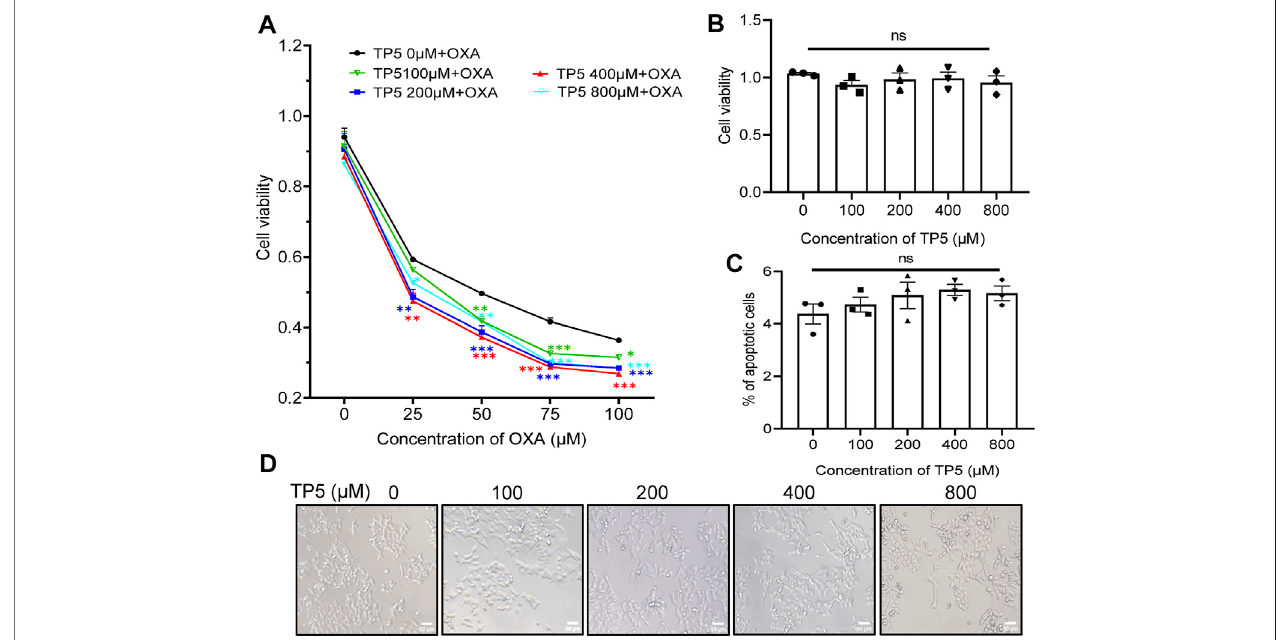
FIGURE6| TP5promotestheanti-proliferativeeffectofOXAoncoloncancercells. (A) TheHCT116cellviabilitymeasuredbyMTTassayatdifferentconcentrations of TP5 and OXA. HCT116 cells were exposed to different concentrations of TP5 (0, 100, 200, 400, and 800 μ M) and OXA (0, 25, 50, 75, and 100 μ M) for 48 h. (B) The HCT116 cell viability measured by MTT assay after treatment with TP5for 48 h only. (C) Apoptosis ofHCT116 cells analyzed by Annexin V/PI stainingby fl ow cytometry after treatment with different concentrations of TP5. (D) Morphological changes observed in TP5-treated HCT116 cells and untreated cells. Scale bar = 50 μ m. All dataareexpressed asmean±SD;* p < 0.05,** p < 0.01 and*** p < 0.001,two-way ANOVAwithDunnett ’ sposthoctest (A) ,F(4,50)=25.15, p < 0.0001,and one-way ANOVA with Dunnett ’ s post hoc test (B) and (C) , F (4, 10) = 0.6217, p = 0.6575, (C) , F (4, 10) = 1.132, p = 0.3952; ns, not signi fi cant.